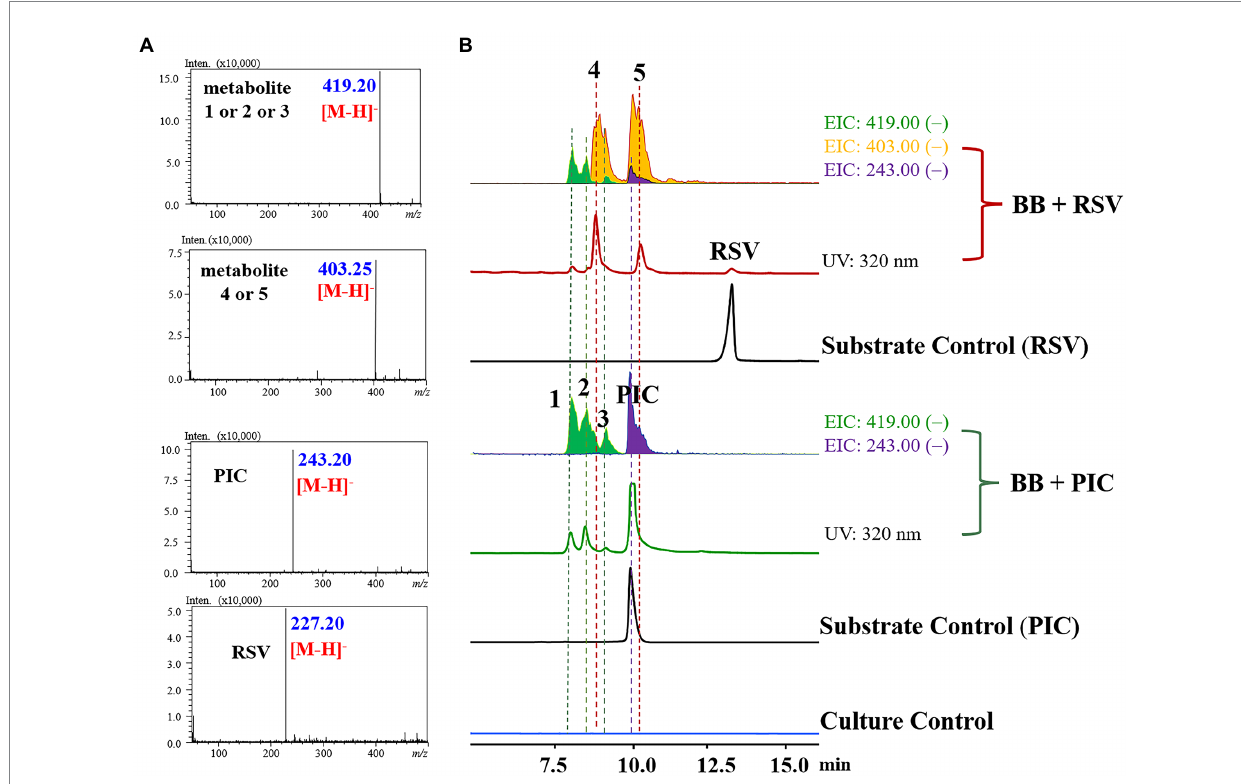
FIGURE 1 HPLC–MS results for the biotransformation products of RSV and PIC by Beauveria bassiana ( A : MS data; B : LC–MS profile). BB + RSV or BB + PIC group infers EIC analysis and HPLC chromatogram of the products of RSV or PIC transformed by B. bassiana for 3 days; Substrate control consisted of sterile medium containing the same amount of substrate under the same conditions but without the strain; Culture control consisted of fermentation blanks in which the strain was grown under the same conditions but without the substrate.